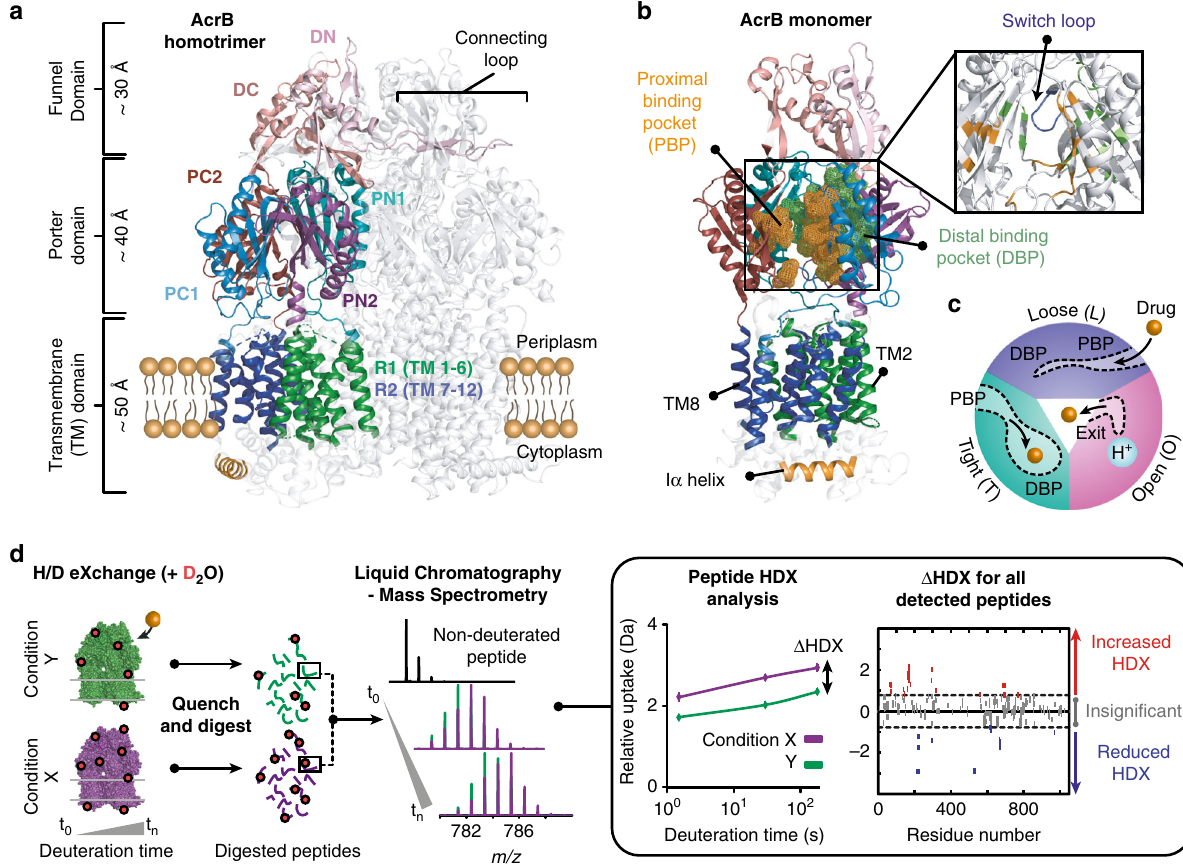
Fig. 1 Summary of structure, function, and HDX-MS of AcrB. a Structure and subdomains of AcrB (PDB:2HRT). b Highlighted regions of functional interest on AcrB monomeric unit. c Functional rotation drug ef fl ux mechanism between the three distinct monomer conformations within trimeric AcrB. d HDX-MS work fl